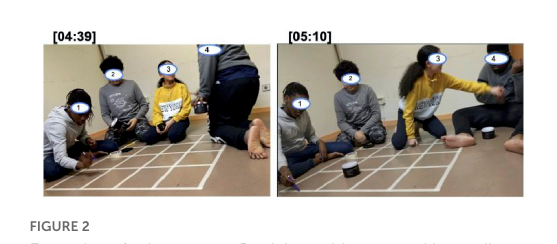
FIGURE3 Examples of collective turns. All four participants are engaged with the activity of throwing the box (participant 1 throws the box to participant 3 who, in turn, passes it to participant 4). Participant 2 is demonstratively attending the passing of the